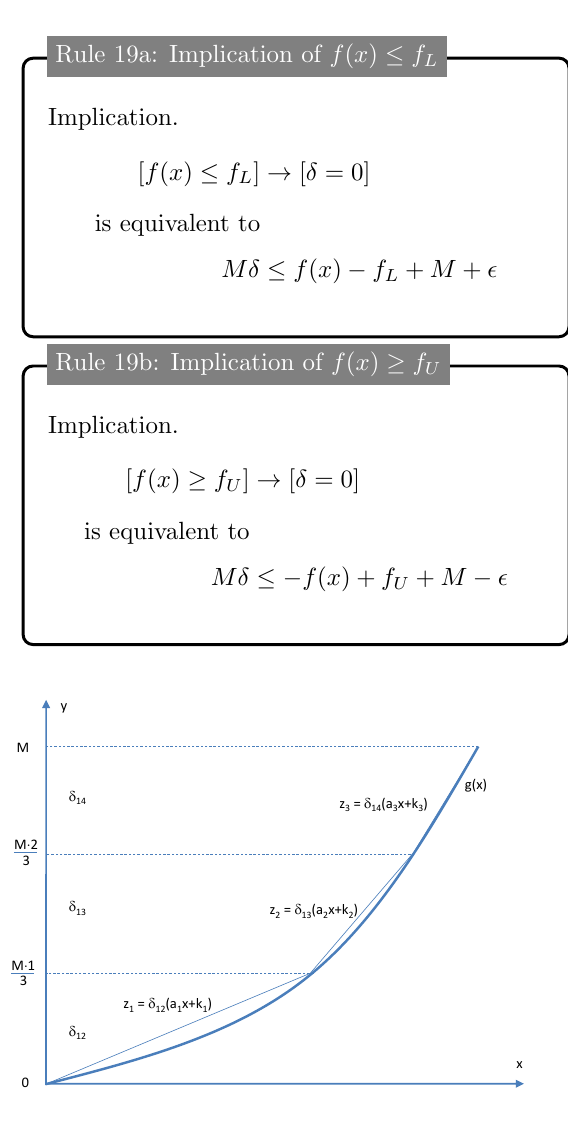
Figure 3: Illustration of mixed-integer linear approxi- mation of a nonlinear positive function g ( x ) with three regions ( δ 12 , δ 13 and δ 14 ).